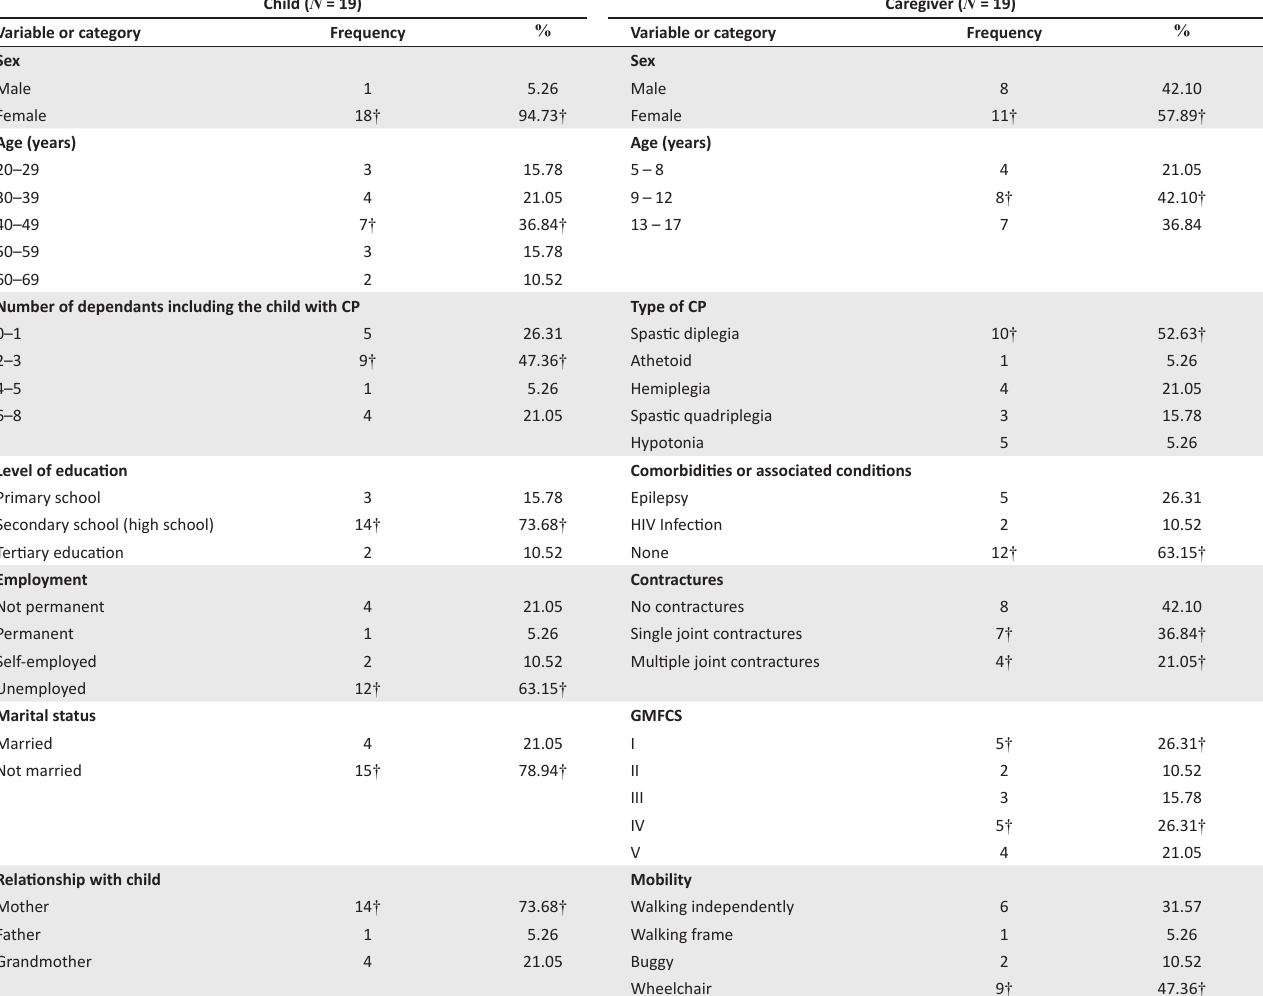
TABLE 1: Bio-demographic and socioeconomic data of caregivers and their children with cerebral palsy ( N = 19). Child ( N =